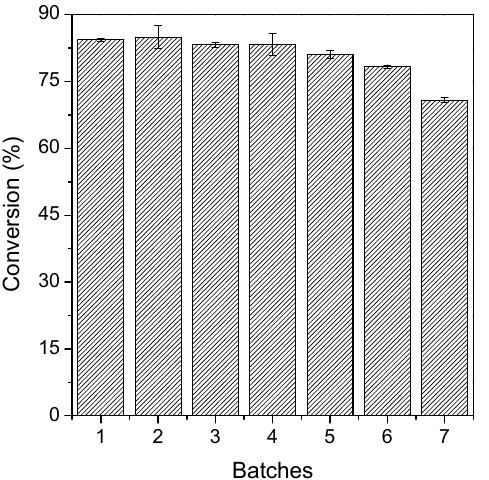
Figure 6. Reusability tests of TLL–Octyl–SiO 2 after seven consecutive batches of ester synthesis of each 150 min each in a heptane medium. The reactions were performed at 56 °C, 240 rpm, acid:alcohol molar ratio 1:3, and biocatalyst concentration of 800 U.